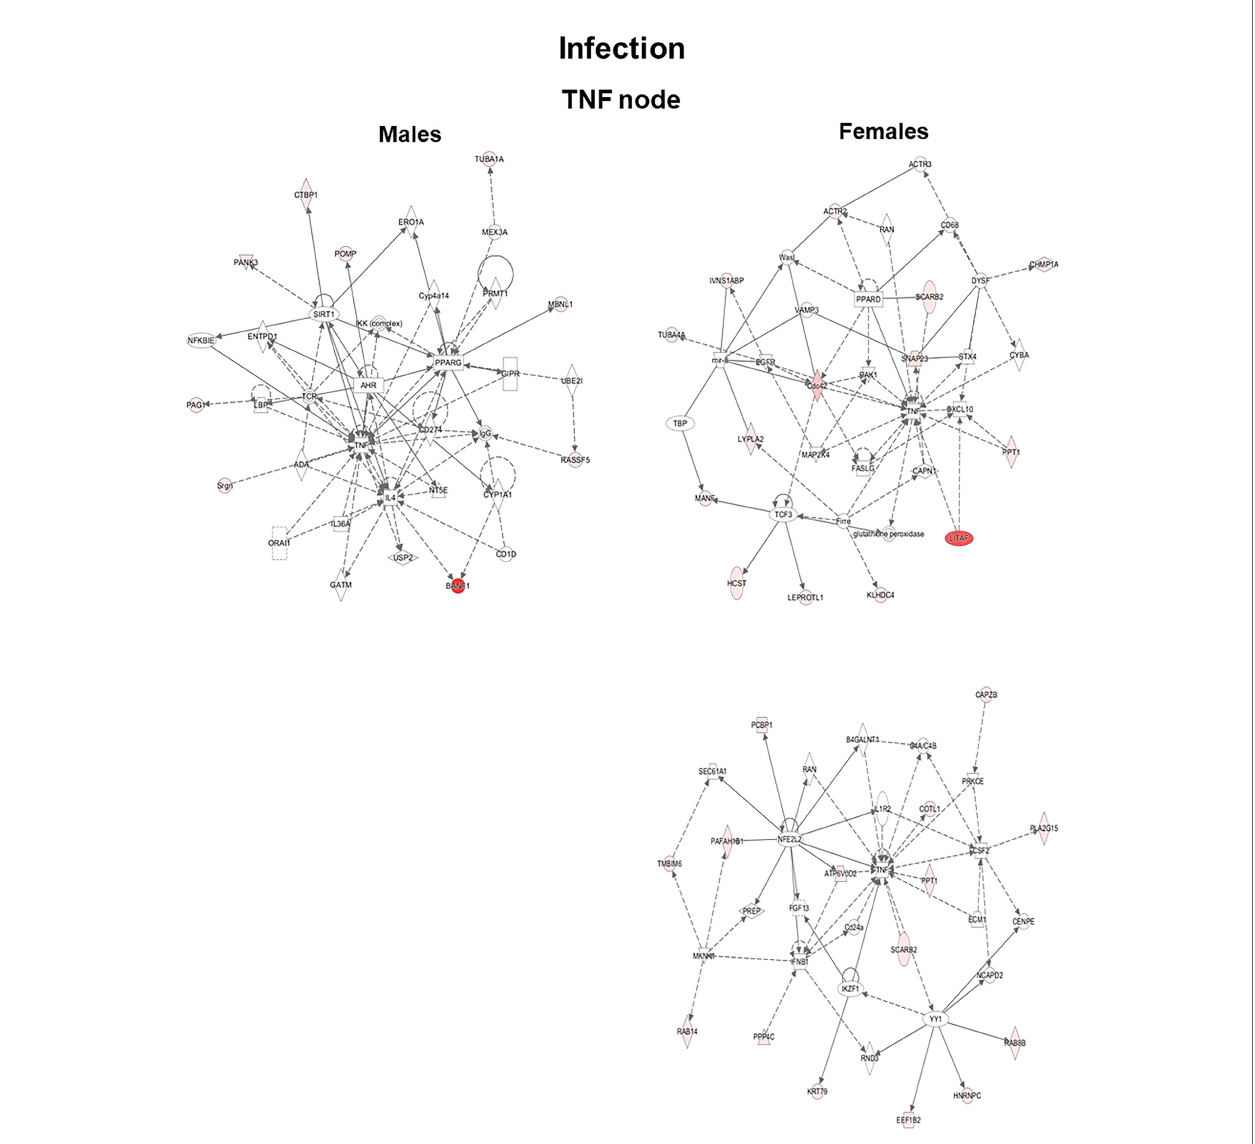
FIGURE 4 | Ingenuity pathway analysis. Biological networks for the TNF signaling of genes with ≥ 2-fold changes in their expression level are shown for the KO LAC of both sexes at 6 h after infection. Direct and indirect gene interactions are marked with solid and dashed lines, respectively. Networks on the left and right show one pathway for male mice and two pathways for female mice, respectively. The different shapes depict different functional classes as follows: Square and concentric (double) circles denote cytokines and complex/groups, respectively. Diamonds denote peptidases and enzymes. Ovals denote transmembrane receptors and transcription regulators; triangle, kinases and phosphatases; rectangles, ion channels, G-protein-coupled receptors, and ligand-dependent nuclear receptors; and trapezoids, microRNAs and